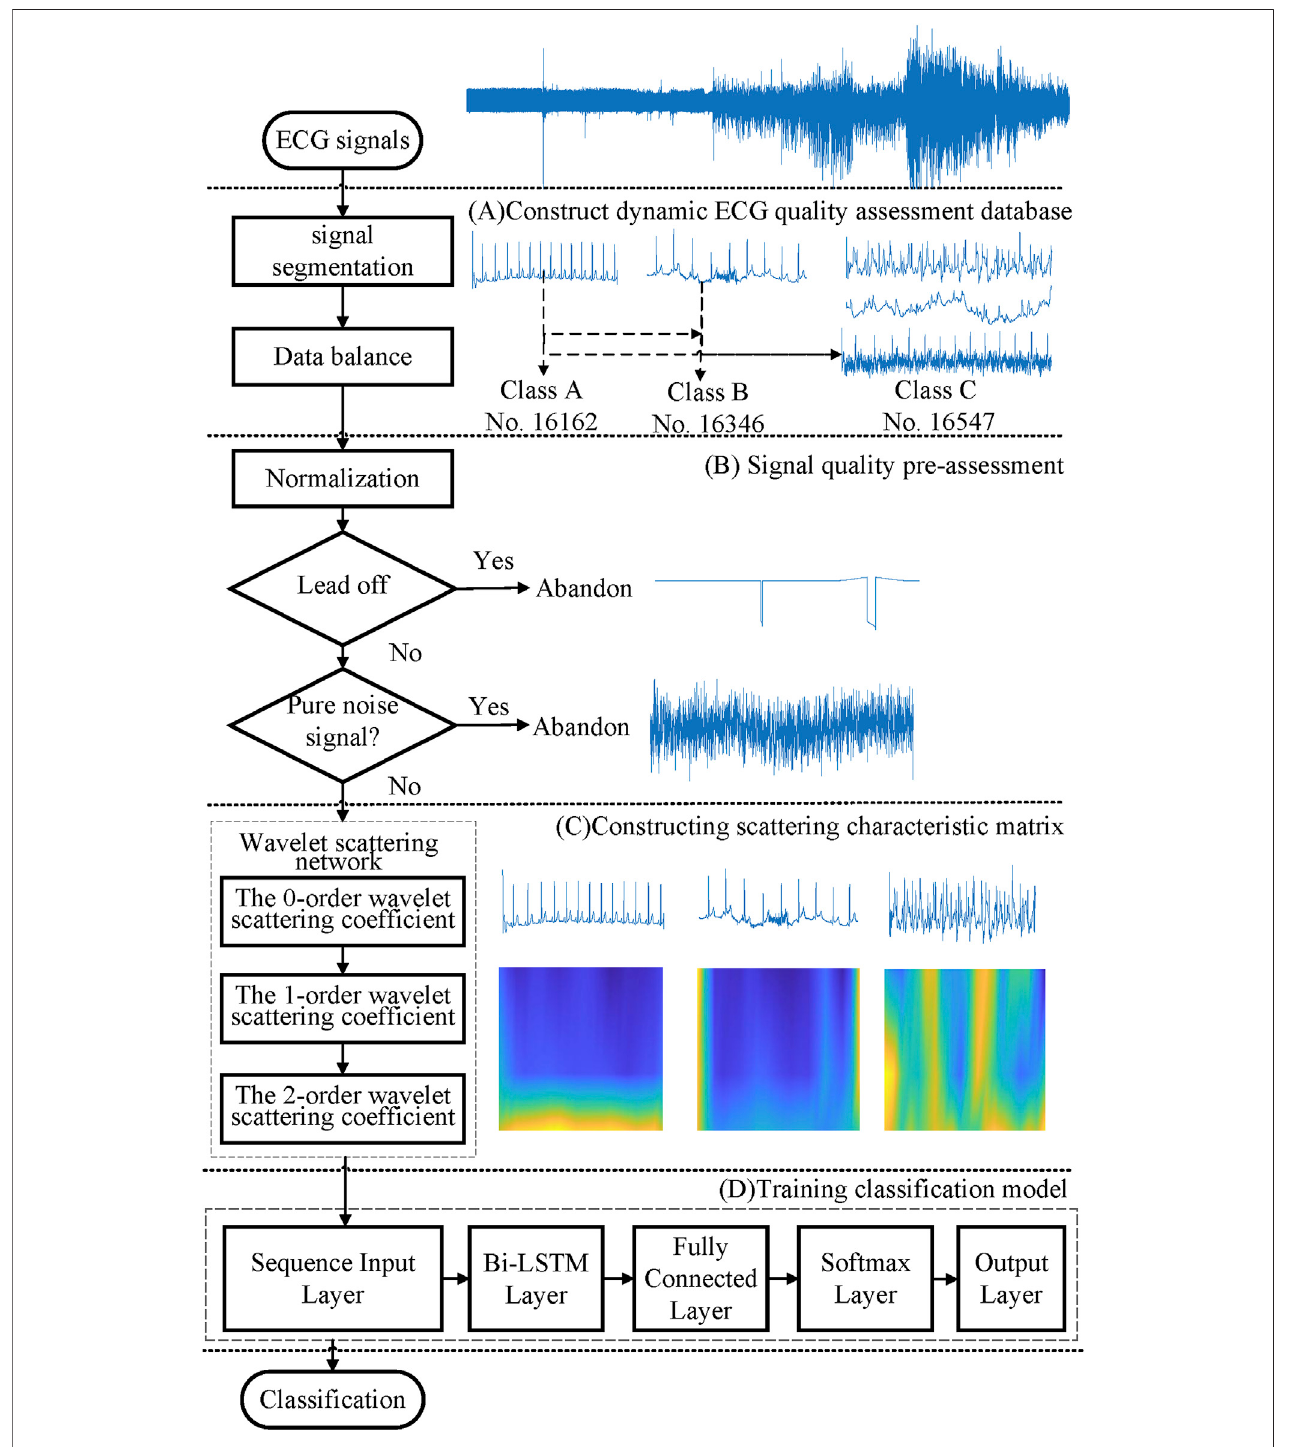
FIGURE 1 | Flowchart of the proposed